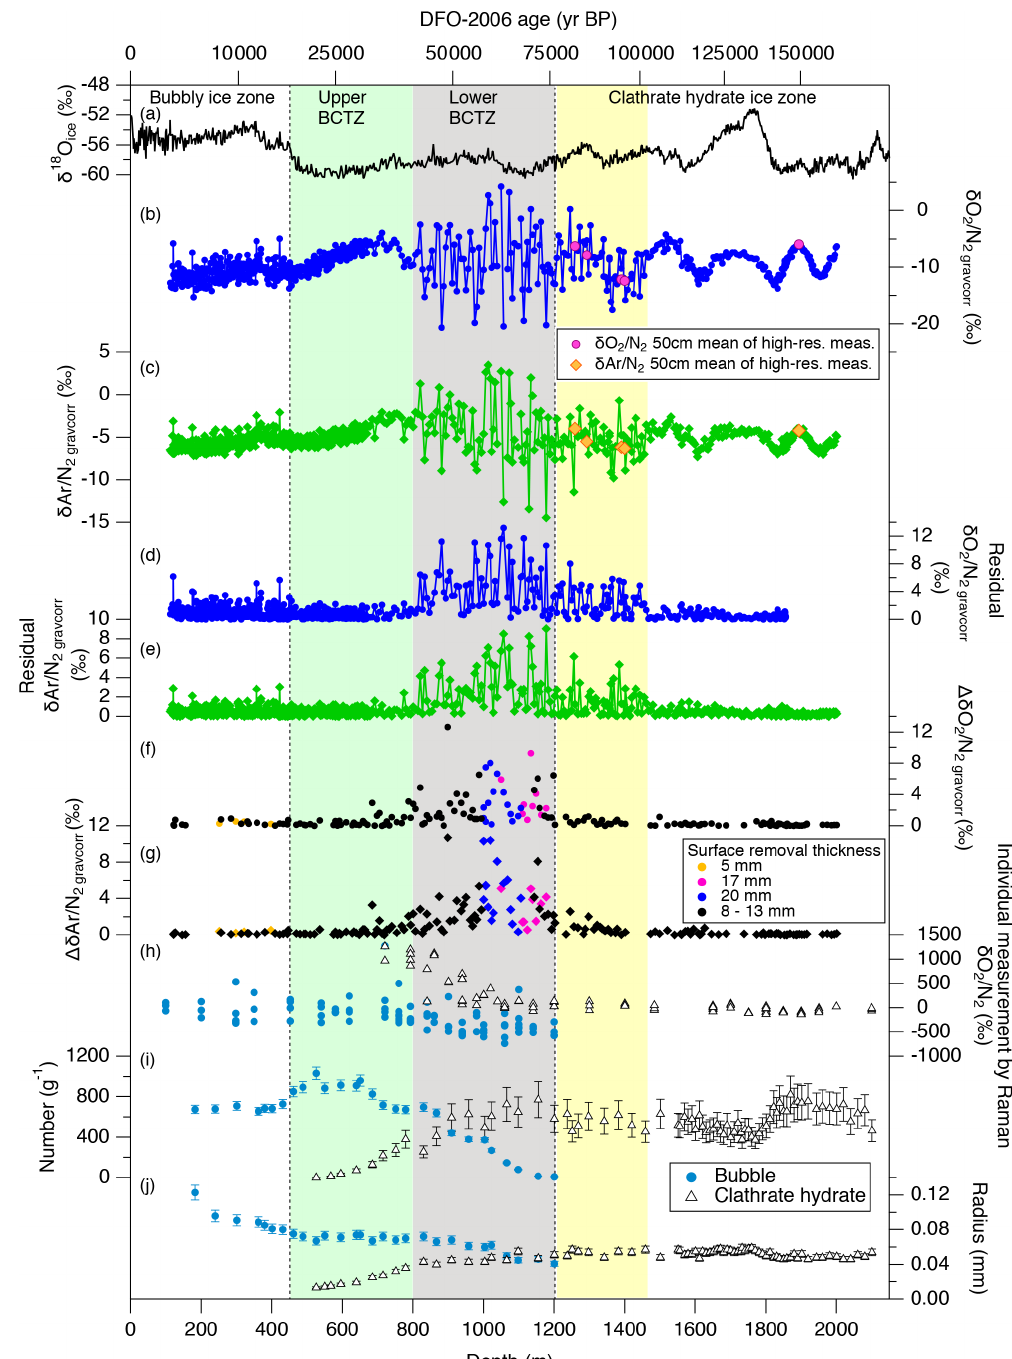
Figure 3. δ O 2 / N 2gravcorr and δ Ar / N 2gravcorr records from the Dome Fuji ice core. Published data of water isotopes and air inclusions are also shown. (a) Stable water isotope record (Uemura et al., 2018), (b, c) δ O 2 / N 2gravcorr and δ Ar / N 2gravcorr after gravitational correc- tions, (d, e) absolute residuals of δ O 2 / N 2gravcorr and δ Ar / N 2gravcorr from their low-pass-filtered curves, (f, g) absolute pair differences of δ O 2 / N 2gravcorr and δ Ar / N 2gravcorr , (h) δ O 2 / N 2 in bubbles and clathrate hydrates observed by Raman spectroscopy (Ikeda-Fukazawa et al., 2001), and (i, j) number concentrations and radius of bubbles and clathrate hydrates (Ohno et al.,